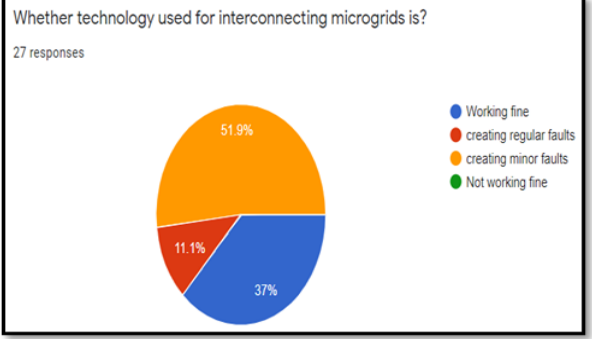
Figure 8. Responses about how technology works in interconnected Microgrids.